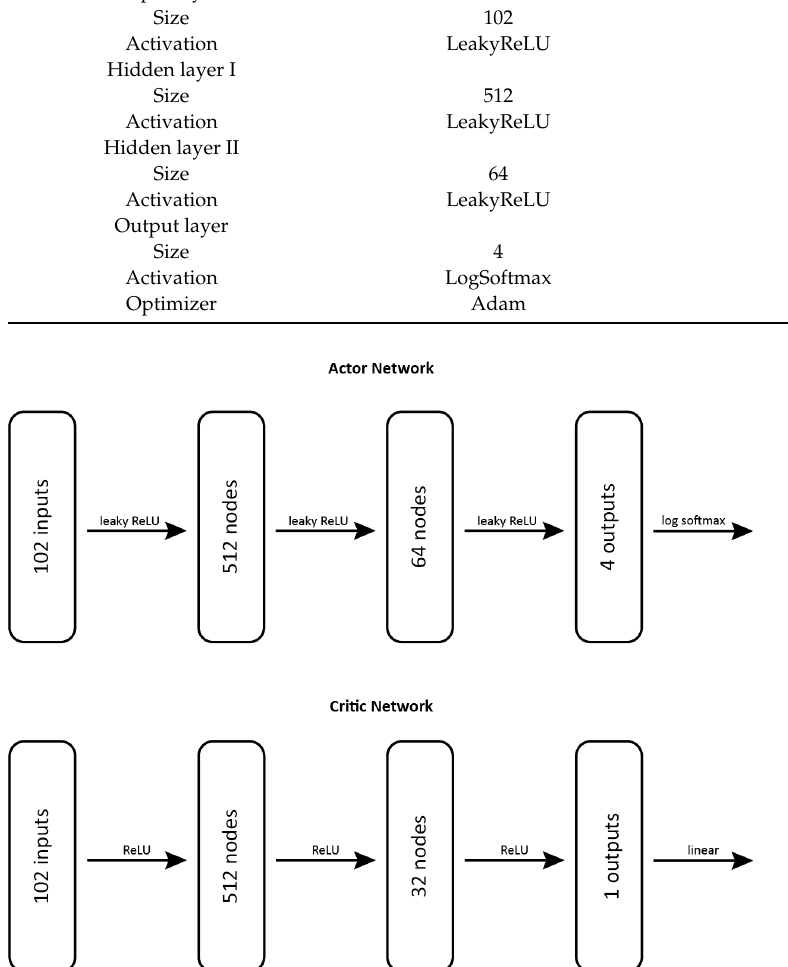
Figure 1. The layout of the networks used in this paper. Both of the networks consist of two hidden layers, with a similar number of nodes. The critic network uses half of the nodes in the second layer, due to the singular output and linear activation. In the actor network, the activation function of the layers was chosen to be a leaky ReLU, in order to allow for some small negative values to be passed on to allow discouraging of some